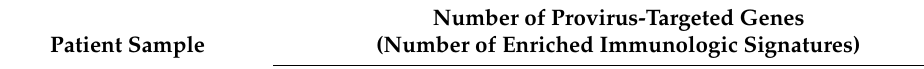
Table 2. The number of provirus-targeted genes (from Table 1) associated with signatures of immune cell types and proinflammatory soluble